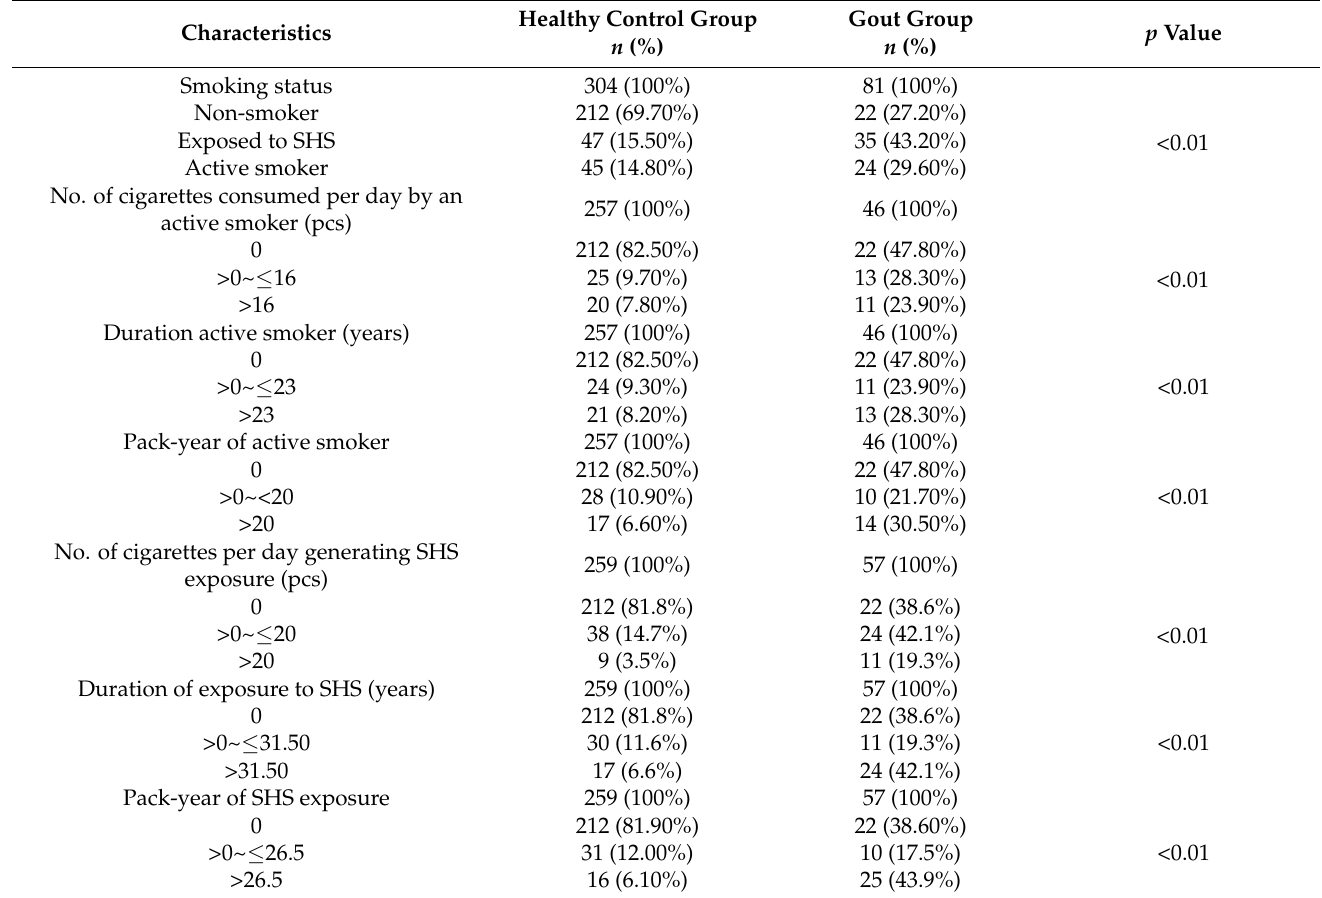
Table 2. Distributions of Potential Risk Factors Between Healthy Controls and Patients with Gout ( N = 385).